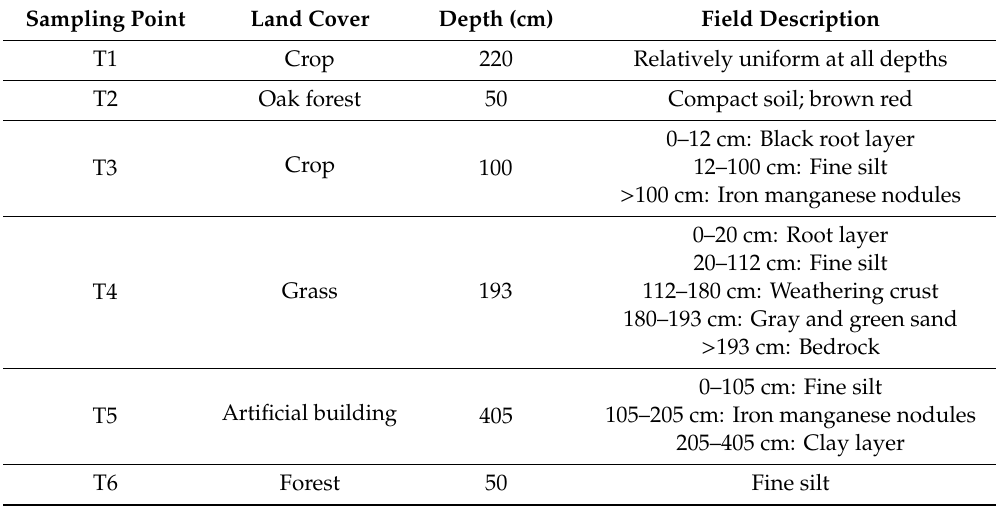
Figure 1. Map of elevation ( a ) and land cover types ( b ) in the Mun River Basin (Data of elevation come from the website: https://opentopography.org/start). Table 1. General description of the sampling